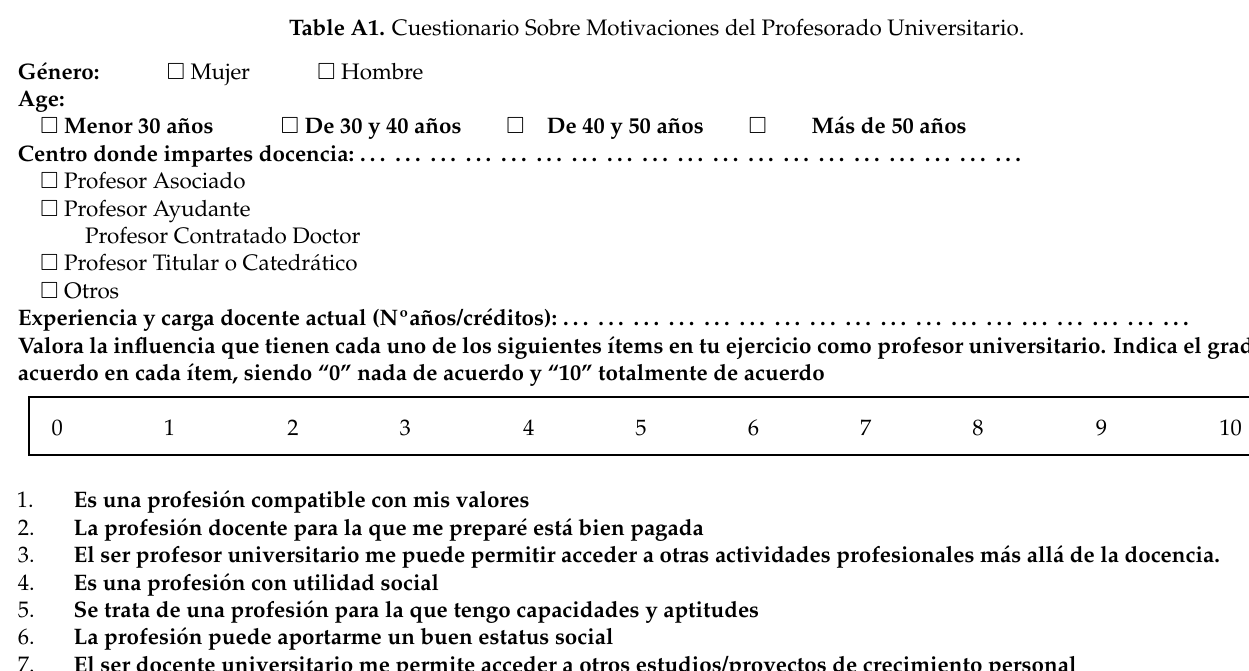
Table A1. Cuestionario Sobre Motivaciones del Profesorado